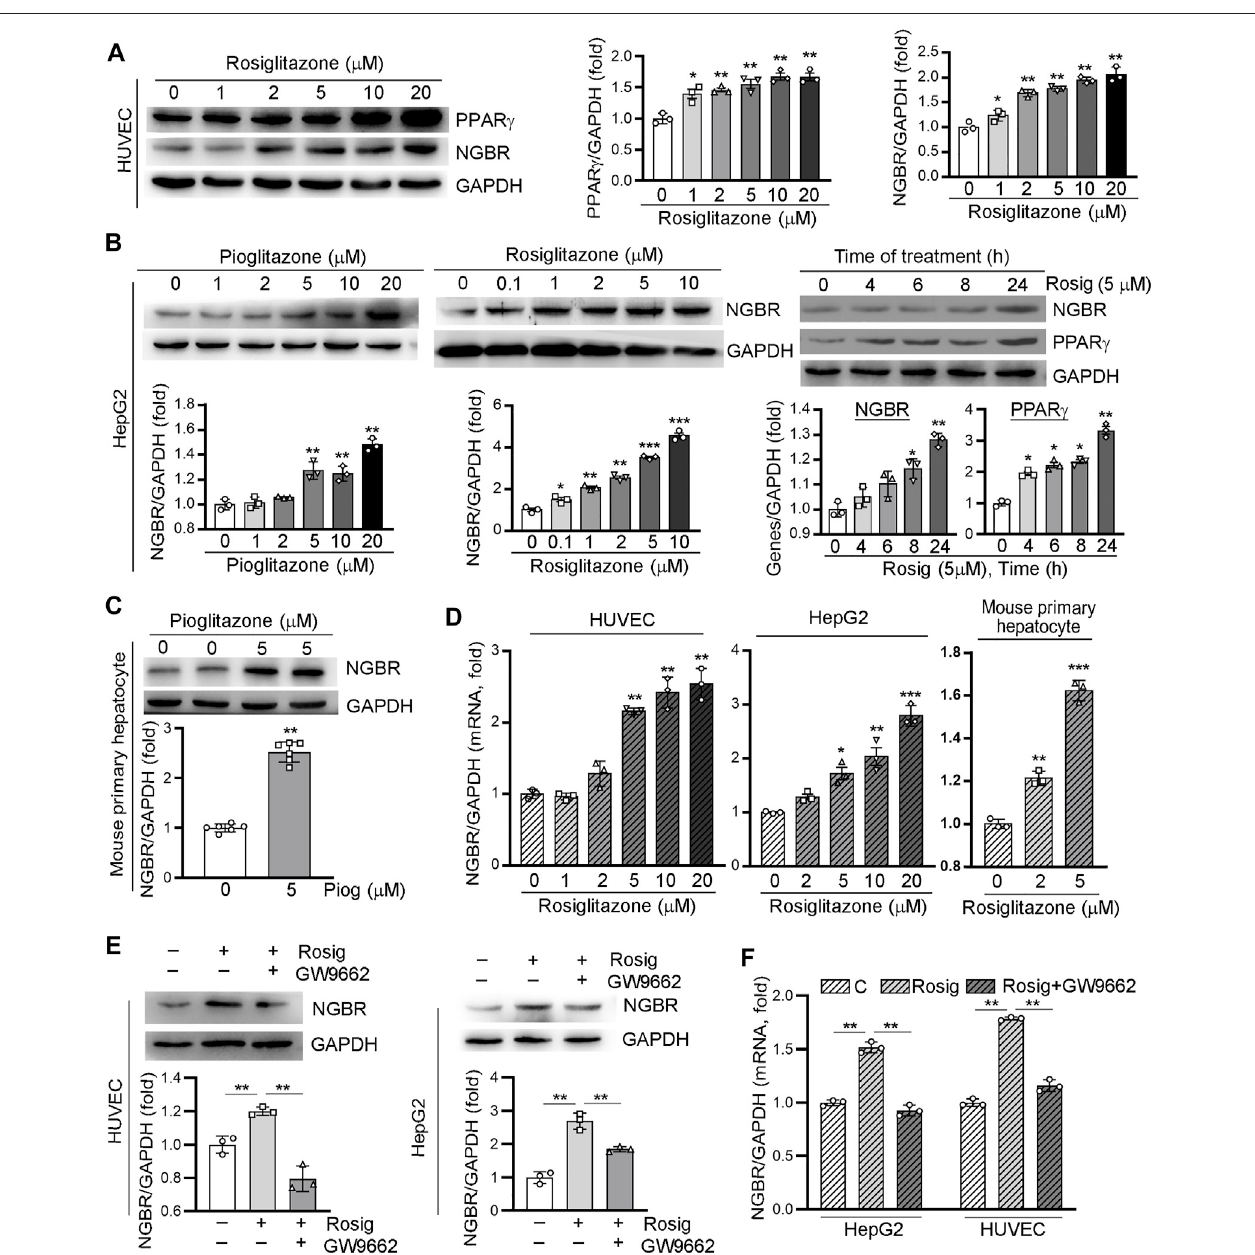
FIGURE 1 | Activation of PPAR γ by ligand induces NGBR expression. (A – D) HUVECs, HepG2 cells and mouse primary hepatocytes were treated with rosiglitazone or pioglitazone at the indicated concentrations for 24 h or pioglitazone (5 μ M) for the indicated times. (E,F) HUVECs or HepG2 cells were treated withrosiglitazone(10 μ M)withorwithoutGW9662(10 μ M)for24 h.LevelsofPPAR γ andNGBRproteinsandmRNAwasdeterminedbyWesternblot (A-C,E) orqPCR (D,F) , respectively. Values were expressed as means ± SD, * p < 0.05; ** p < 0.01; *** p < 0.001 vs control ( n (cid:1) 3).